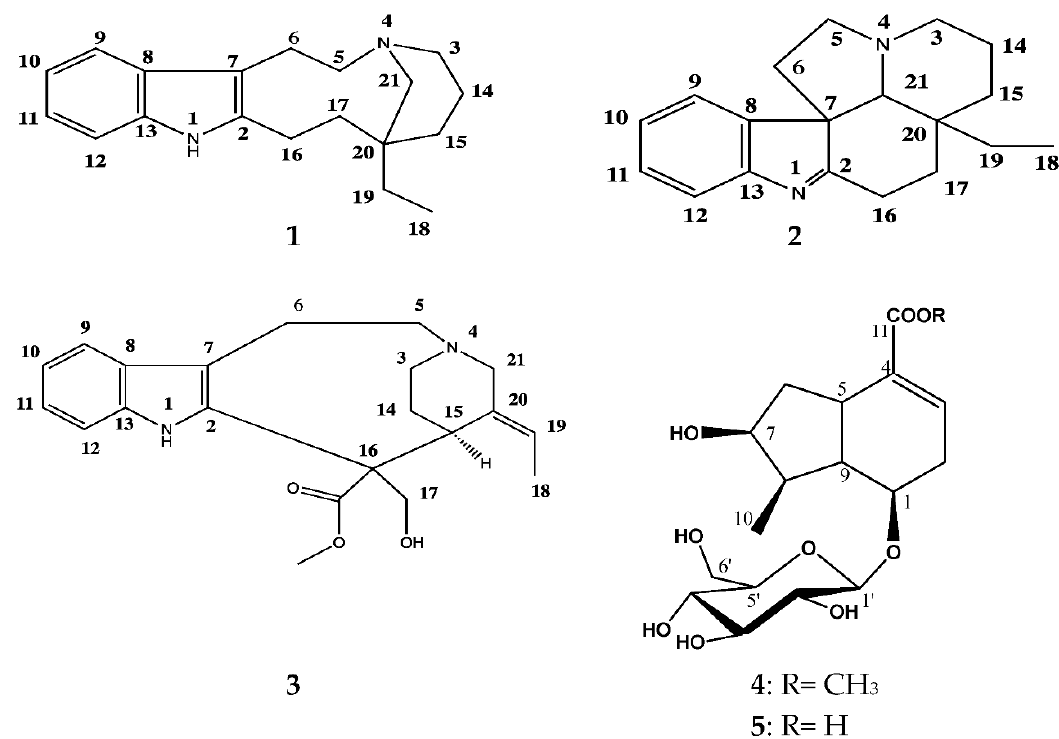
Figure 3. Structures of the isolated compounds 1–5 .